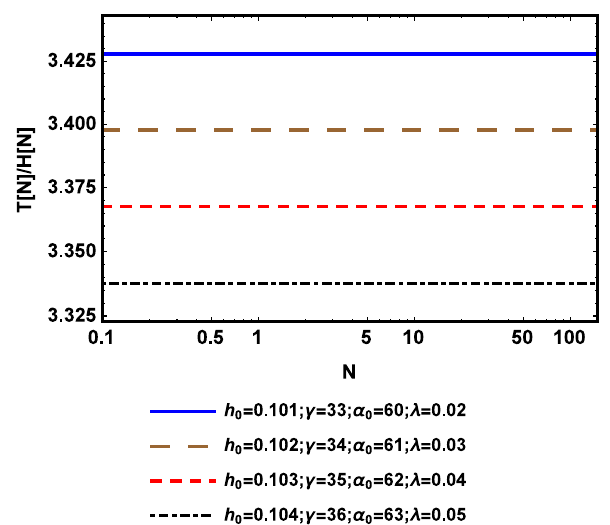
Fig. 4 The ratio of the temperature to the Hubble parameter during the inflationary evolution of the non-comoving model in the weak regime with generalized de Sitter scale factors versus the number of e-folds, for different values of the parameters of the